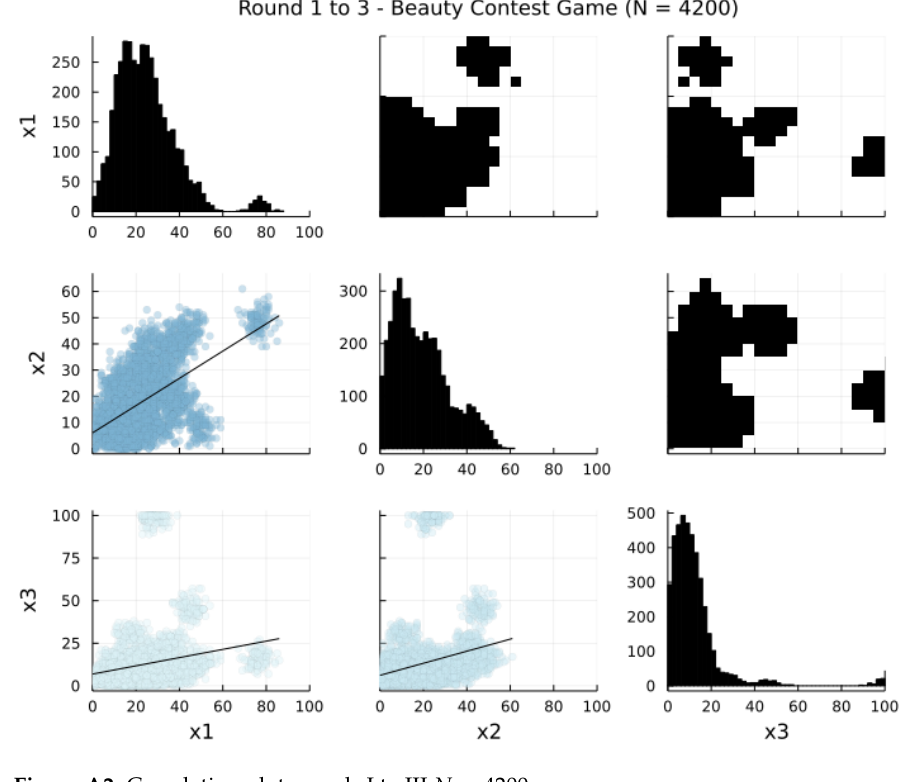
Figure A2. Correlation plot rounds I to III N = 4200.